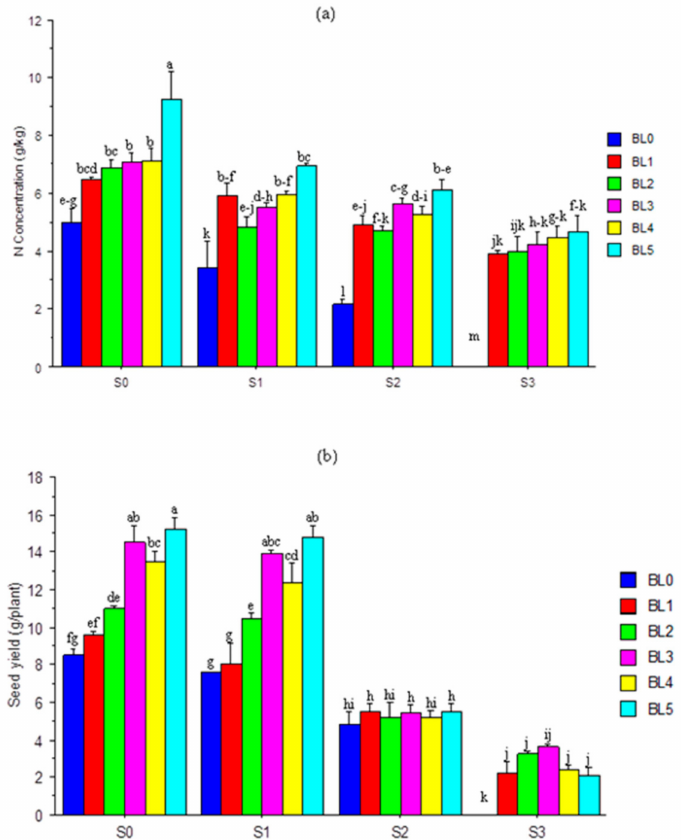
Figure 7. Interaction effects of salinity × brassinolide on seed- N concentration ( a ) and yield of soybean ( b ) at harvest. BL—brassinolide; S—salinity; BL0—no BL application (control); BL1—BL application at seedling; BL2—BL application at flowering; BL3—BL application at podding; BL4— BL application at seedling + flowering; BL5—BL application at seedling + flowering + podding; S0—1.10 mM/L (control); S1—32.40 mM/L; S2—60.60 mM/L; S3—86.30 mM/L. Mean pairs